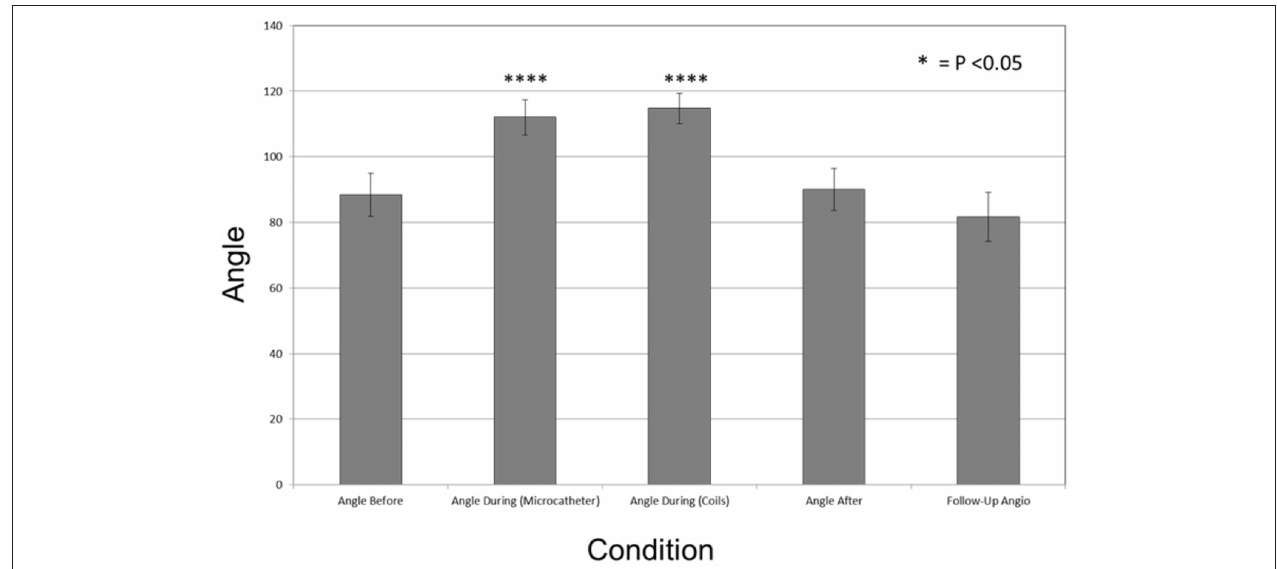
FIGURE 2 | Bar graph plotting the mean degrees of angle change in during the coiling procedure. Angle before (88.42 ◦ + 6.59), Angle during (Microcatheter) (112.03 ◦ + 5.36), Angle during Coils (114.72 ◦ + 4.60), Angle after (90.04 ◦ + 6.39), and Follow-Up Angio (81.58 ◦ + 7.42). The mean angle change between these conditions was 37 ◦ ± 2.5. Vertical line represents Standard Error (SE). during (Microcatheter) and Angles during (Coils) were statistically significant in comparison to the baseline angle before with p < 0.001 and p < 0.001, respectively, and denoted with * p < 0.05, **** p <